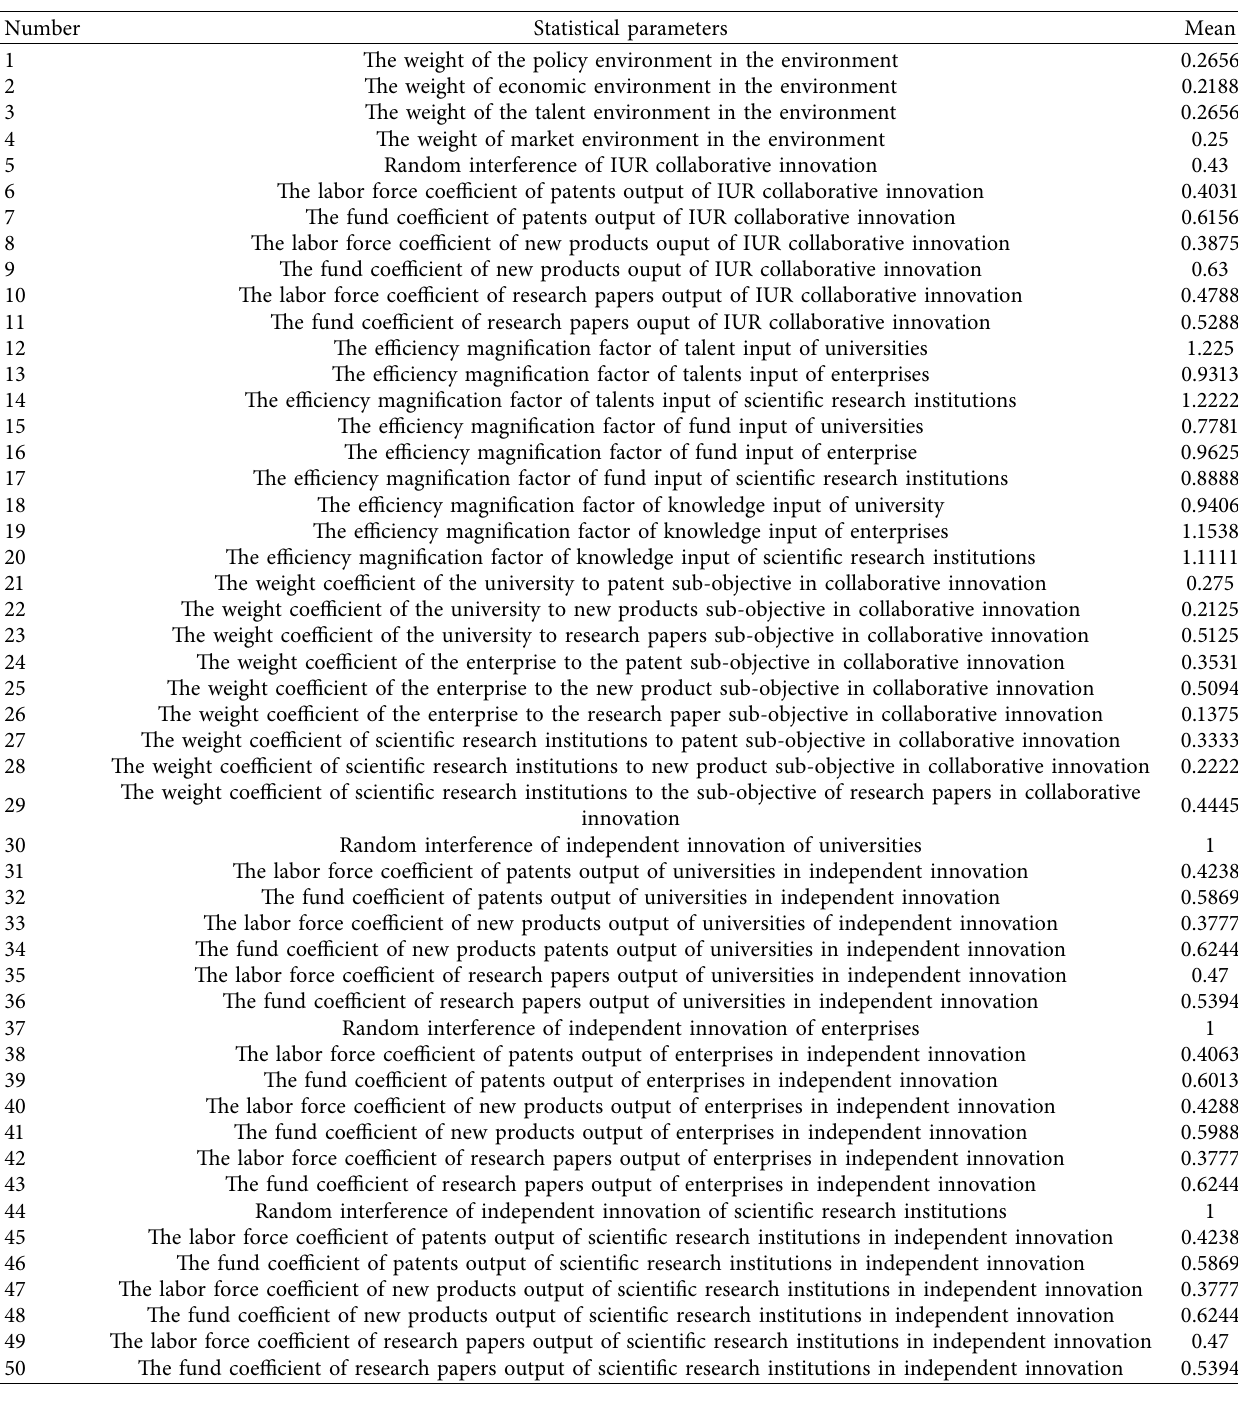
Table 1: Statistical mean of expert